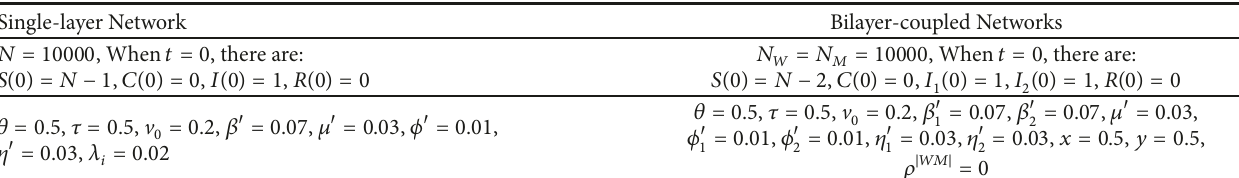
Table 6: Comparison of initial parameters between single-layer network and bilayer-coupled networks. Single-layer Network Bilayer-coupled Networks